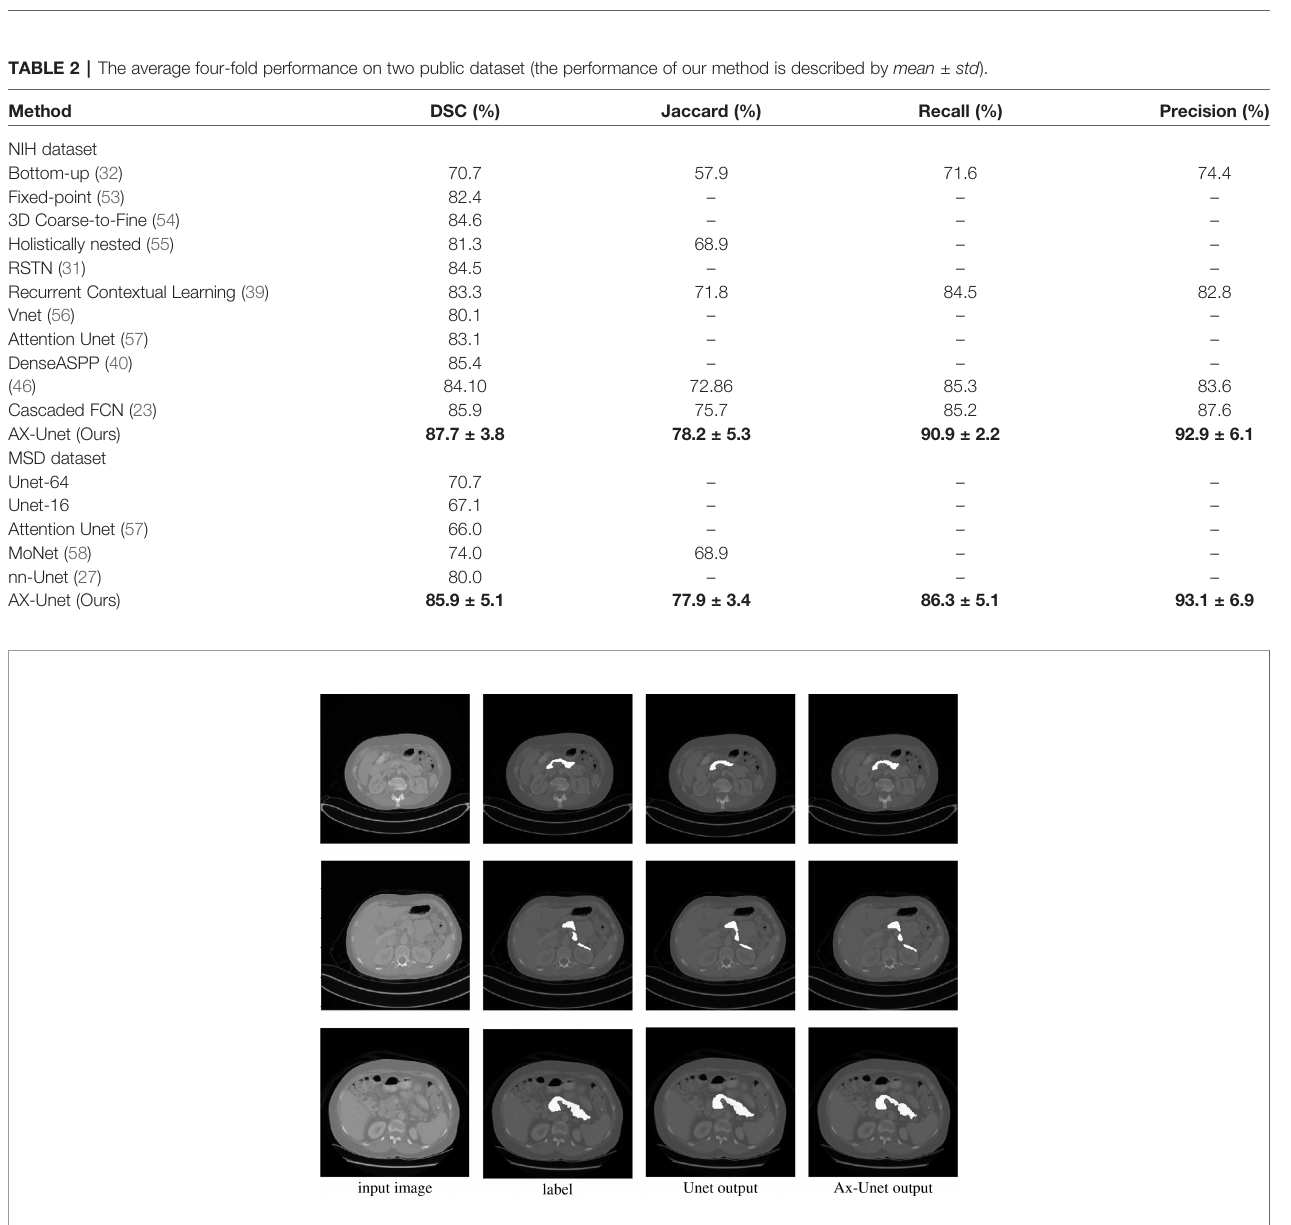
FIGURE 3 | Comparison of segmentation for three examples by the baseline model (Unet) and the AX-Unet, along with the original image and ground truth. In each row, from left to right, the images correspond to the original image, ground-truth segmentation, the baseline segmentation by Unet, and segmentation by our AX- Unet model, respectively. It can be clearly observed that the proposed model has better segmentation effect of the boundary than the baseline.